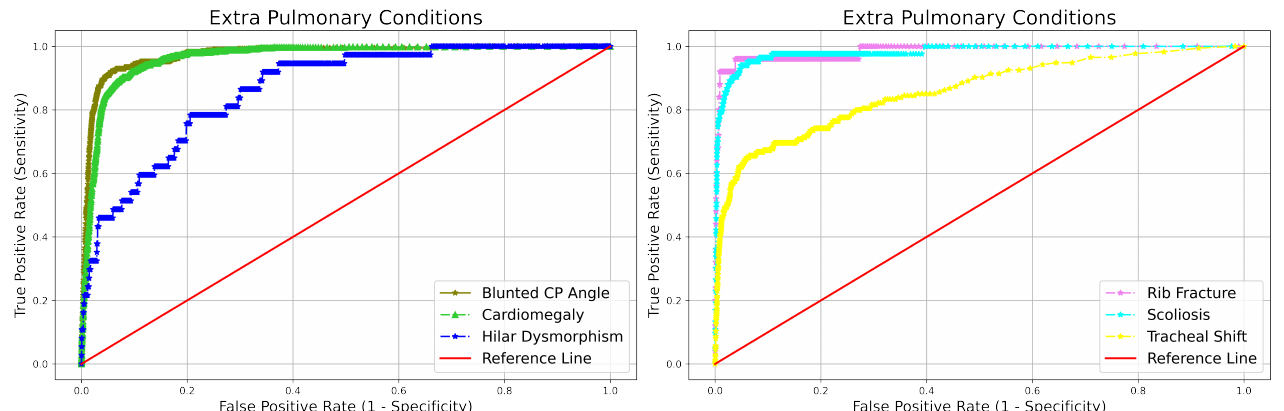
Figure 4. ROC curve qXR performance in identifying subabnormality from abnormal CXR and categorizing into extra